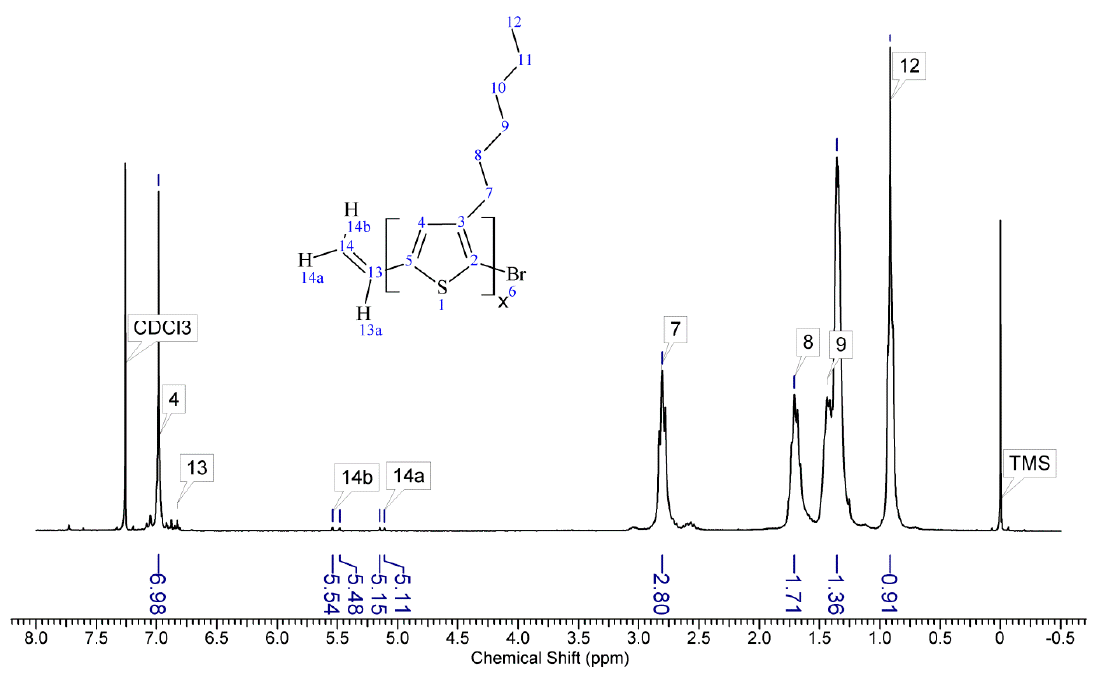
Figure A1. spectrum of vinyl terminated regioregular P3HT ( P3HTvin ).